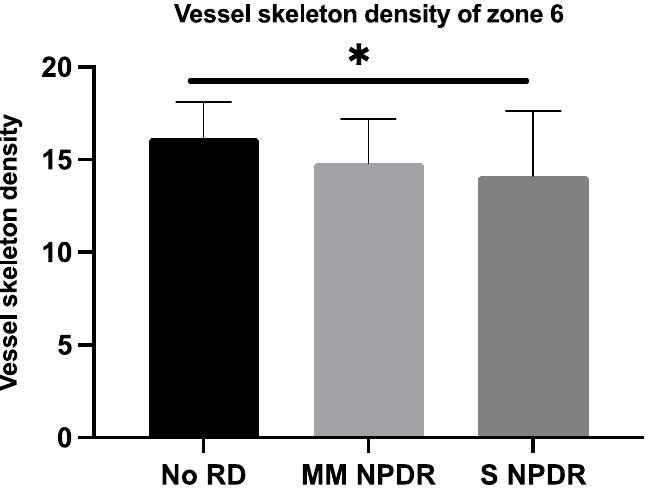
Figure 6. Mean vessel skeleton density with standard deviation for each group (without DR, mild and moderate NPDR, and severe NPDR) in zone 6. * p < 0.05. DR, diabetic retinopathy; MM NPDR, mild and moderate non-proliferative diabetic retinopathy; S NPDR, severe non-proliferative dia- betic retinopathy.